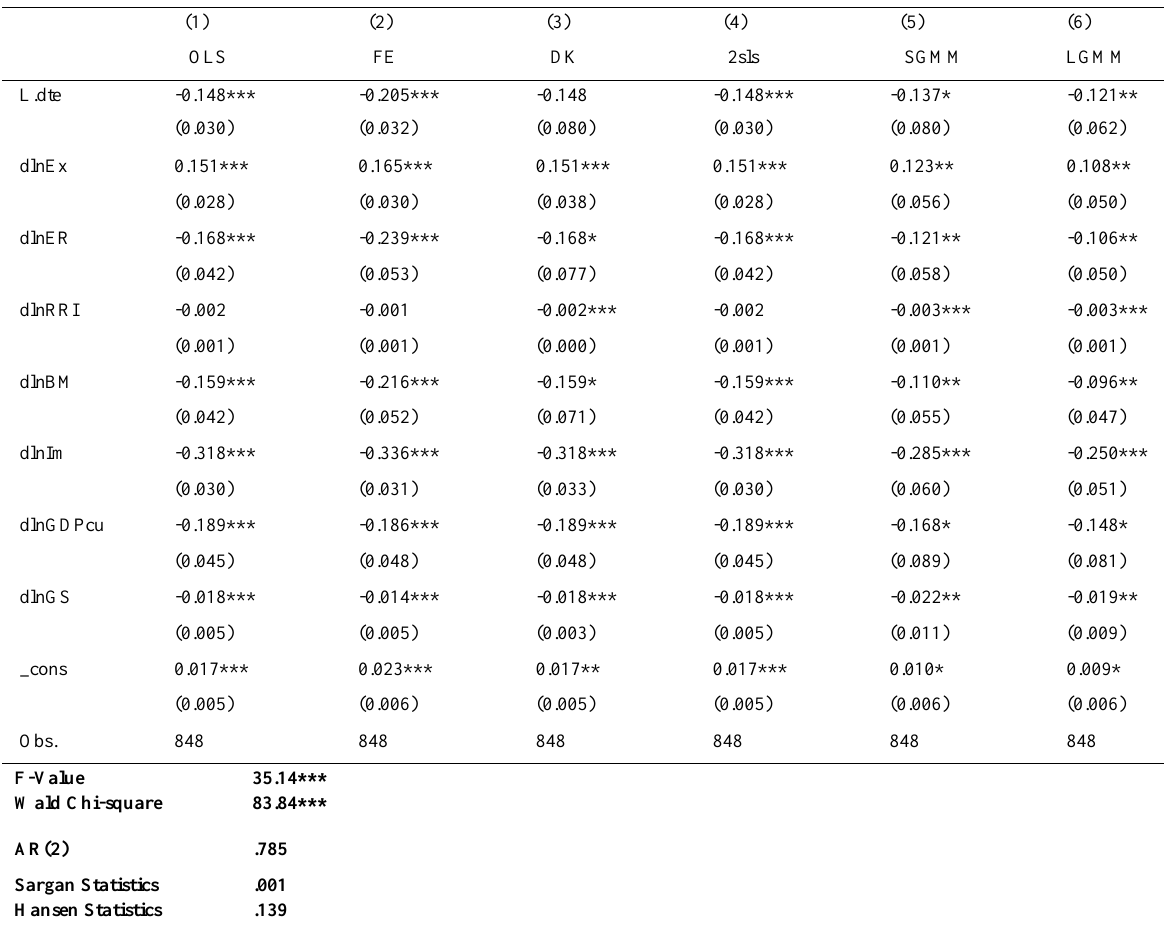
Table 11: Determinants of wealth maximizing technical efficiency with GDPppp